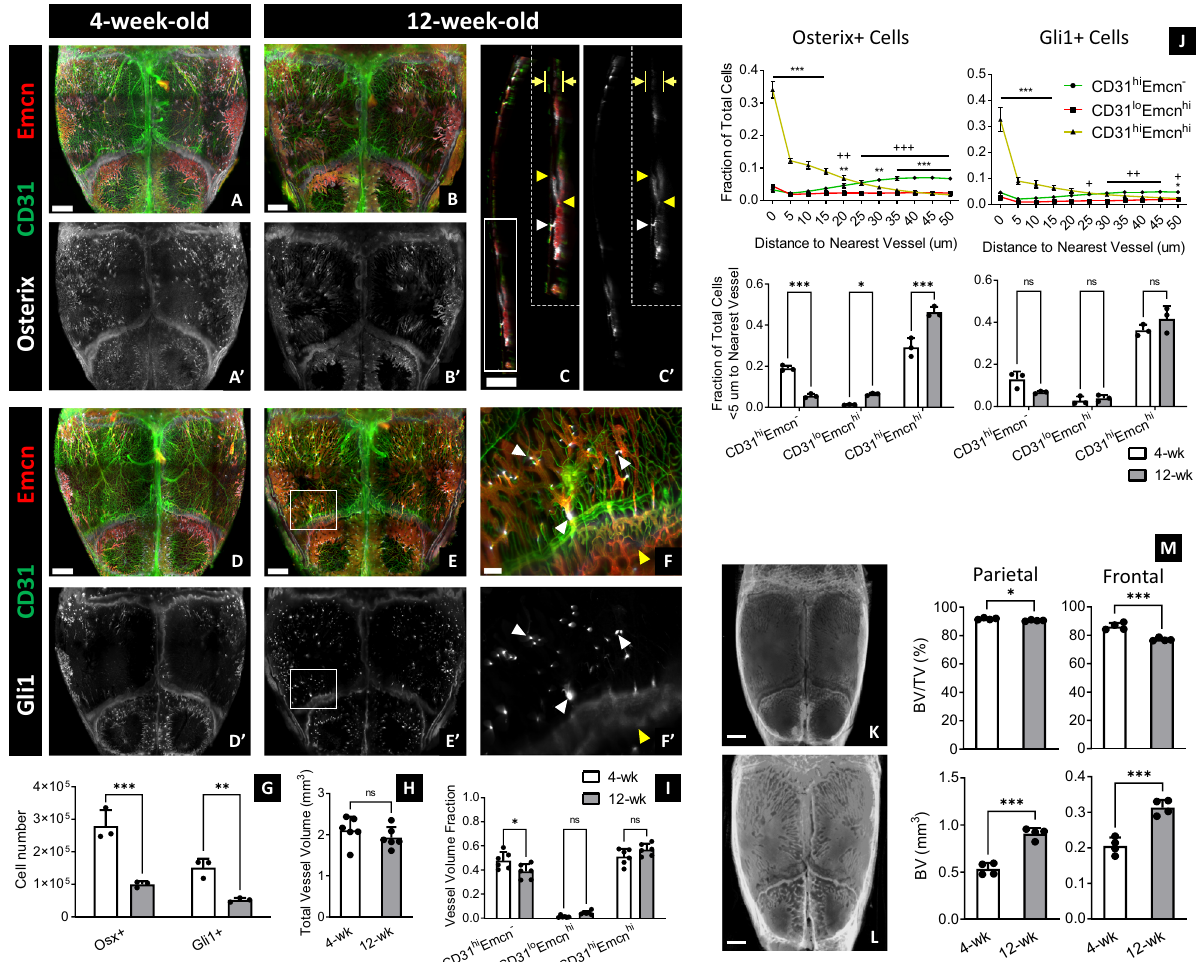
Fig. 3 Changes in vessel phenotype and skeletal progenitor distribution following postnatal development. A , B MIP of vessels and Osterix + progenitors from calvaria of 4-weeks-old ( A , A ’ ) and 12-weeks-old ( B , B ’ ) mice. C 40- μ m-thick sagittal section showing vessels ( C ) and Osterix + progenitors ( C , C ’ ) along the thickness of the calvarium displayed in B . 12-weeks-old calvaria have more bone marrow vessels (CD31 hi Emcn hi and CD31 lo Emcn hi/lo ) and fewer periosteal and meningeal vessels compared to 4-weeks-old calvaria. Osterix + progenitors in 12-weeks-old calvaria are spatially restricted to transcortical canals (white arrowheads), bone marrow cavities, and osteogenic fronts adjacent to the sutures (yellow arrowheads), and are absent from the periosteum and dura mater (yellow arrows). D , E MIP of vessels and Gli1 + progenitors of calvaria from 4-weeks-old ( D ) and 12-weeks-old ( E ) mice. F Zoomed-in region from E . Gli1 + cells in 12-weeks-old calvaria ( E , E ’ , F , F ’ ) are concentrated at and nearby the transcortical canals (white arrowheads) and the sutures (yellow arrowheads). Results were replicated in 3 calvaria for each experimental group and staining combination (12 total calvaria). G – I Comparison of total skeletal progenitor number ( G ), total vessel volume ( H ), and fractional vessel phenotype volumes ( I ) between 4- and 12-weeks-old calvaria ( n = 3 for G ; n = 6 for H , I ). J Plots representing the spatial correlation of Osterix + and Gli1 + progenitors to vessel phenotypes ( n = 3). Both cell types maintain a preferential relationship with CD31 hi Emcn hi vessels in 12-weeks-old mice. Osterix + cells demonstrate a higher spatial af fi nity to CD31 hi Emcn hi vessels in 12-weeks-old versus 4-weeks-old calvaria. K , L MicroCT 3D volume projections of calvaria at 4 weeks ( K ) and 12 weeks ( L ) of age. M MicroCT quanti fi cation of bone volume to total volume (BV/TV) percentage and bone volume (BV) in the parietal and posterior frontal bones of 4- and 12-weeks-old mice ( n = 4). Data are mean ± SD. Statistics were performed using a two-way ANOVA with Bonferroni post-hoc test ( G – J ) or two-tailed t - test ( H , M ). *** p < 0.001, ** p < 0.01, * p < 0.05 where designated or between CD31 hi Emcn hi and CD31 hi Emcn − vessels in J ; +++ p < 0.001 between CD31 lo Emcn hi and CD31 hi Emcn − vessels ( J ). Exact p -values for two-tailed t -tests: H p = 0.3321, M p = 0.0213 (top left), 0.0005 (top right), 0.0001 (bottom left), 0.0005 (bottom right). Scale bars: 1000 μ m ( A , B , D , E , K , L ); 700 μ m ( C ); 300 µ m ( C , inset); 200 μ m ( F ). Colors: Red: Endomucin (Emcn), Gray: Osterix ( A – C ) or Gli1 ( D – F ), Green: CD31.